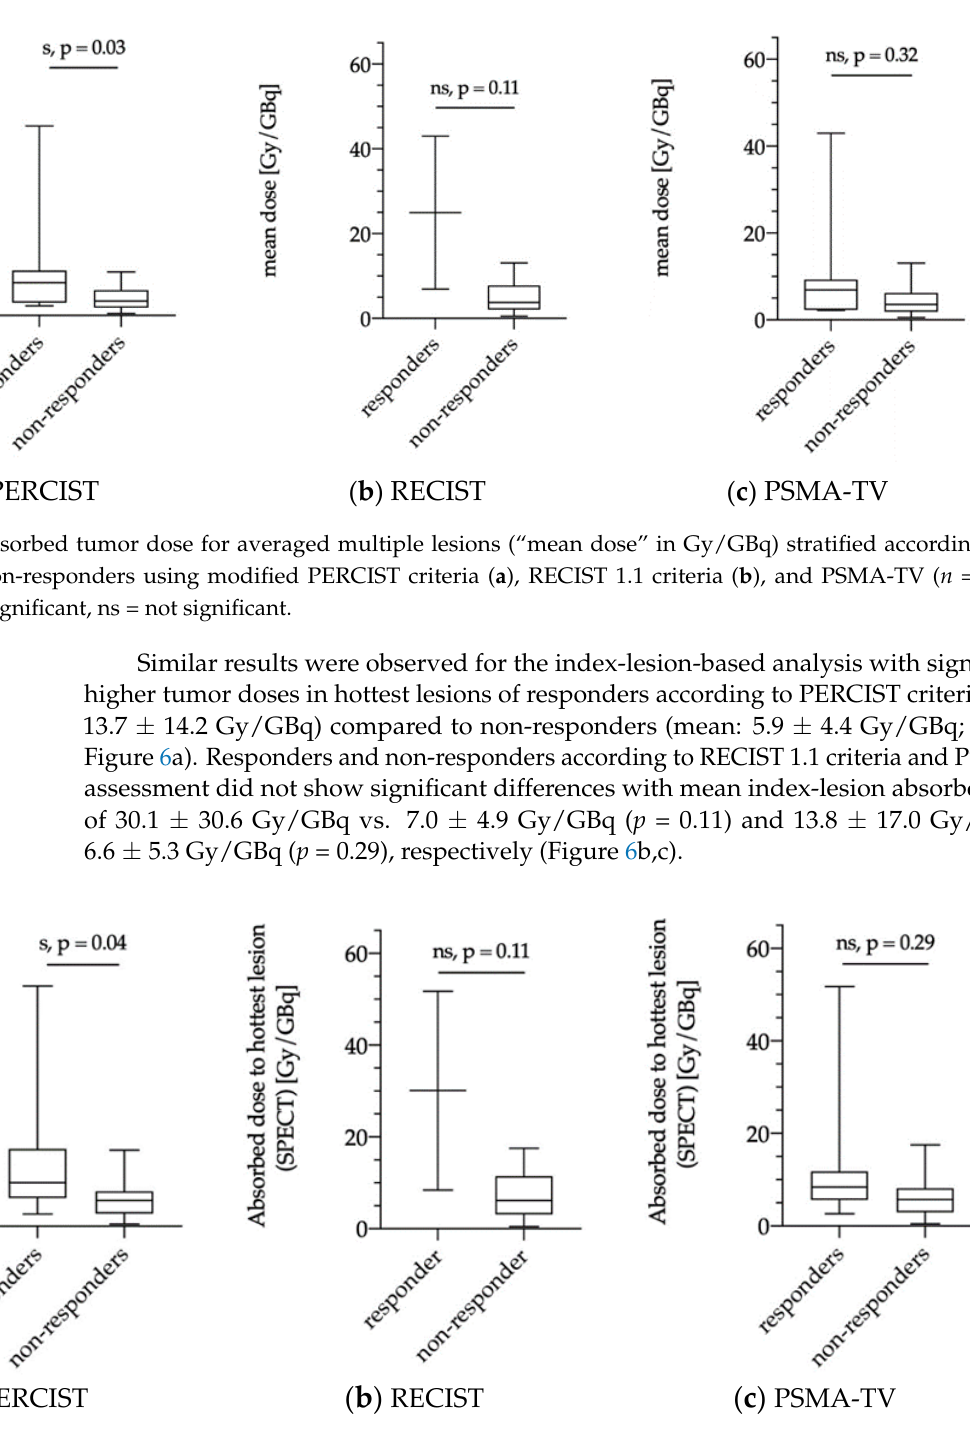
Figure 6. Index-lesion-based dosimetry for single tumor lesions with the highest uptake (“hottest lesion” in Gy/GBq) stratified according to responders and non-responders using modified PERCIST criteria ( a ), RECIST 1.1 criteria ( b ), and PSMA-TV ( n = 21) ( c ). s = significant, ns = not significant.